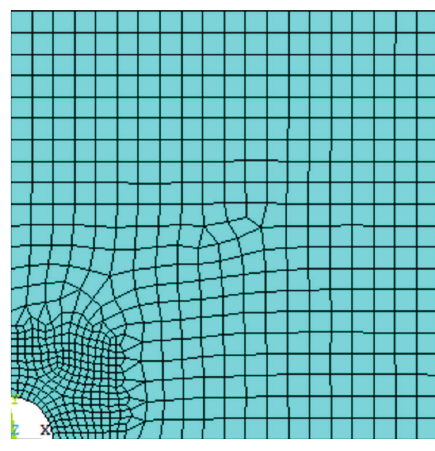
Figure 16: Plane model of borehole.